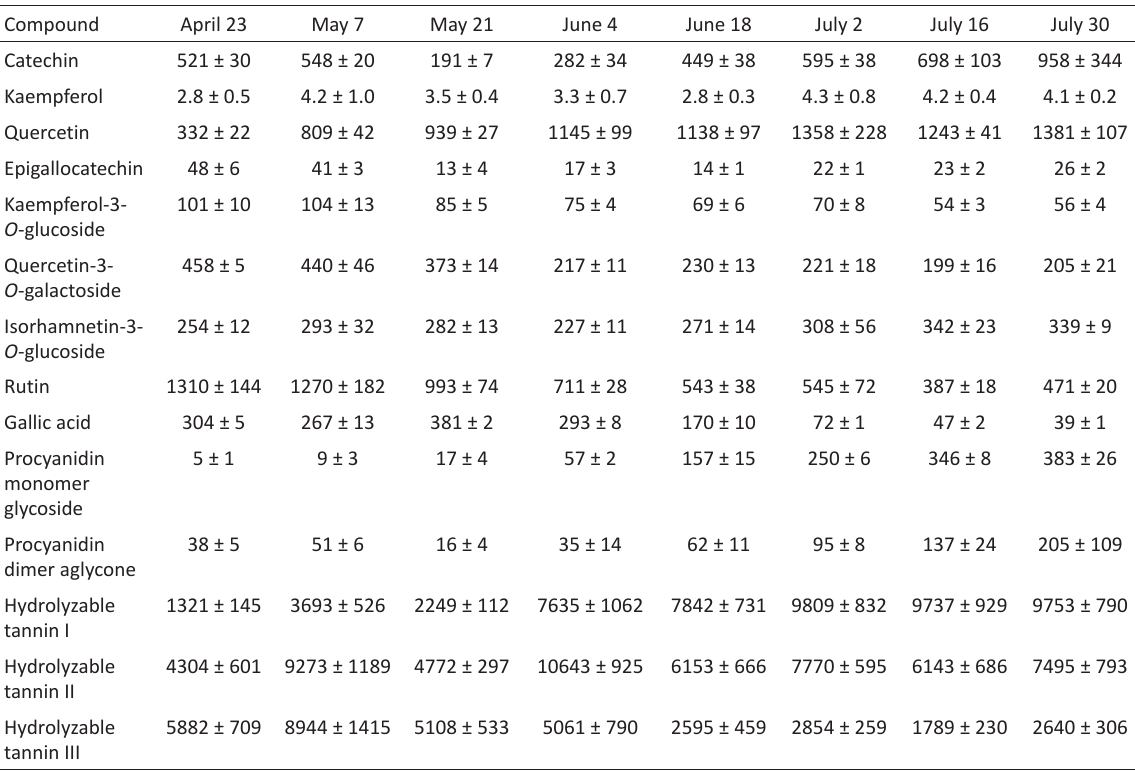
Table 2. Catechin, kaempferol, quercetin (quantified as rutin), epigallocatechin, kaempferol-3- O -glucoside, quercetin-3- O -galactoside (quantified as rutin), isorhamnetin-3- O -glucoside, rutin, gallic acid, procyanidin monomer glycoside and procyanidin dimer aglycone (quantified as catechin) as well as hydrolyzable tannins I-III (quantified as gallic acid) (HPLC-MS analysis) in sea buckthorn leaves of ‘Ljubitelskaja’ for each sampling date, respectively. For each compound the average (in µg/g dry weight) and standard deviation (n=3) is